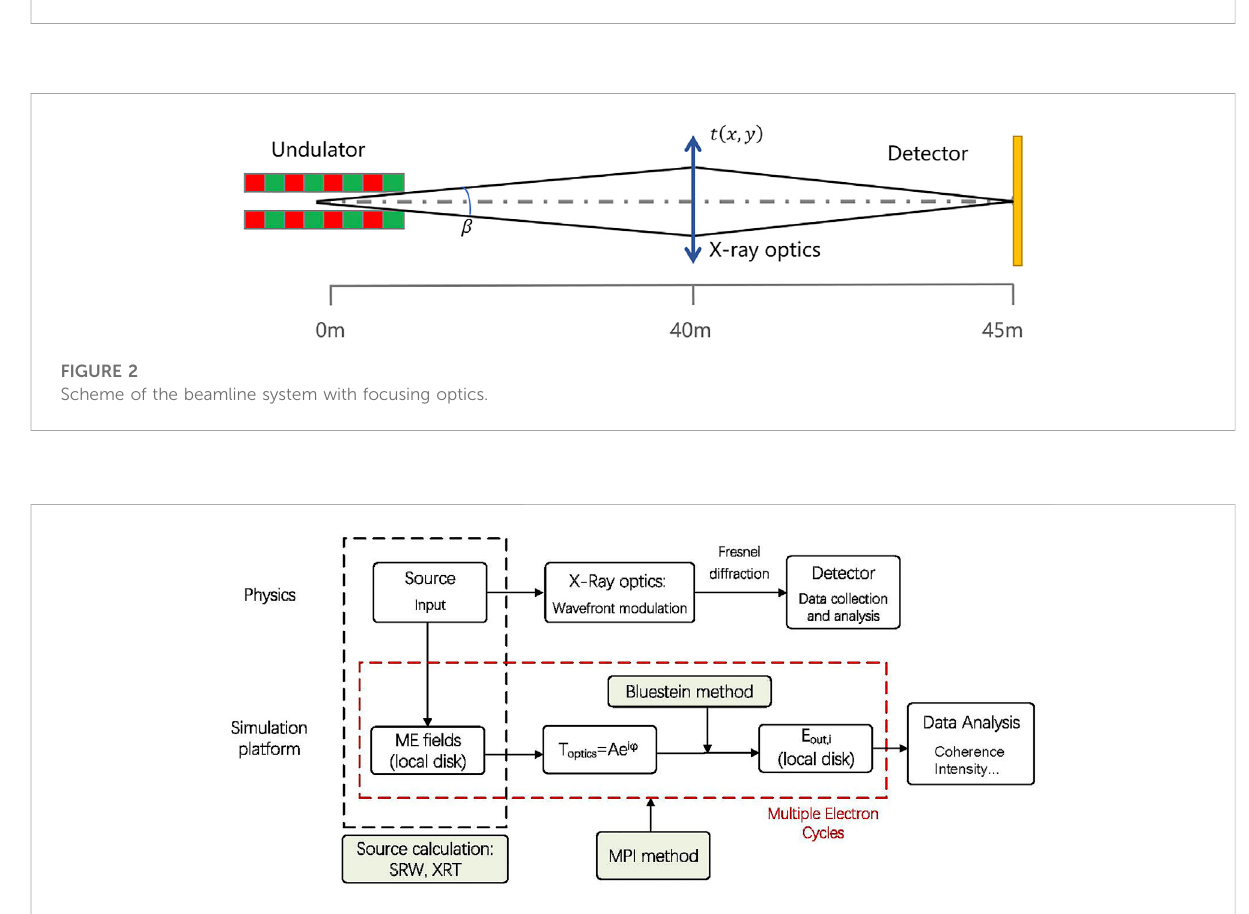
FIGURE 3 Roadmap of the calculation platform for partial coherence system